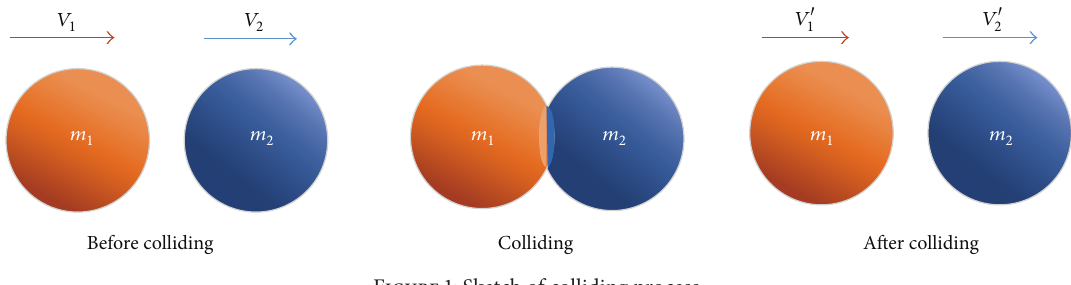
Figure 1: Sketch of colliding process.